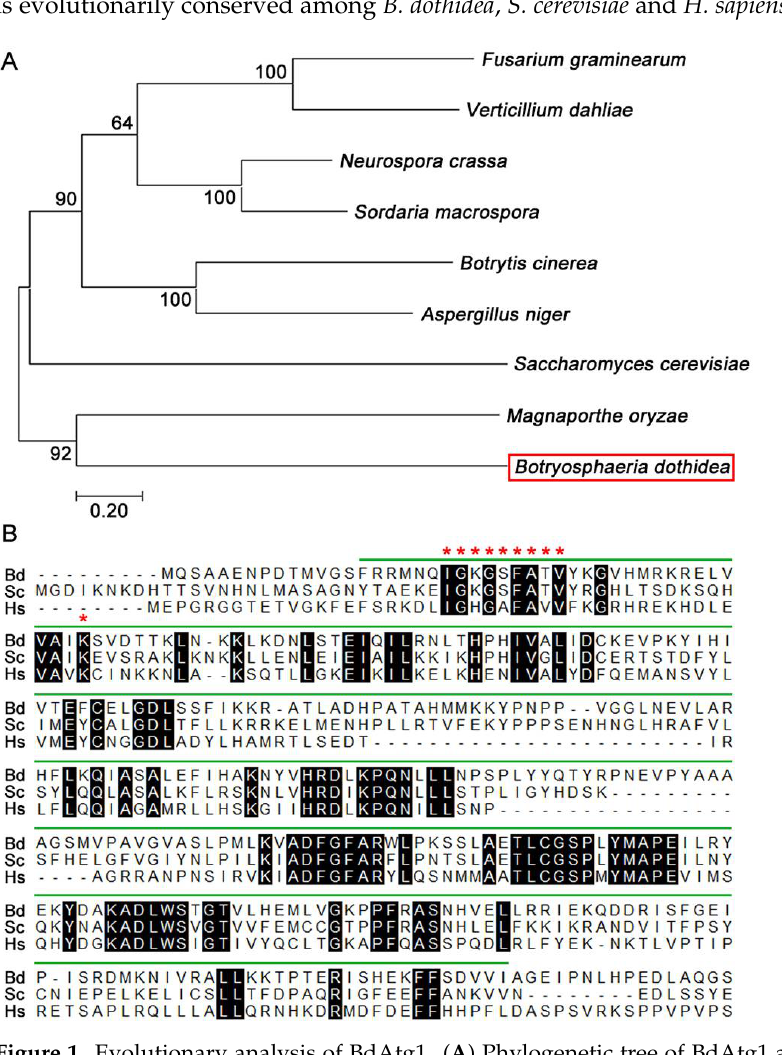
Figure 1. Evolutionary analysis of BdAtg1. ( A ) Phylogenetic tree of BdAtg1 and other orthologs from fungi, including Fusarium graminearum , Verticillium dahliae , Neurospora crassa , Sordaria macrospora , Botrytis cinerea , Aspergillus niger , Magnaporthe oryzae and Saccharomyces cerevisiae . ( B ) Sequence alignment of serine-threonine kinase domains form B. dothidea , S. cerevisiae and Humo sapiens . The green overlines indicate the serine-threonine kinase domain and the red asterisks indicate ATP- binding